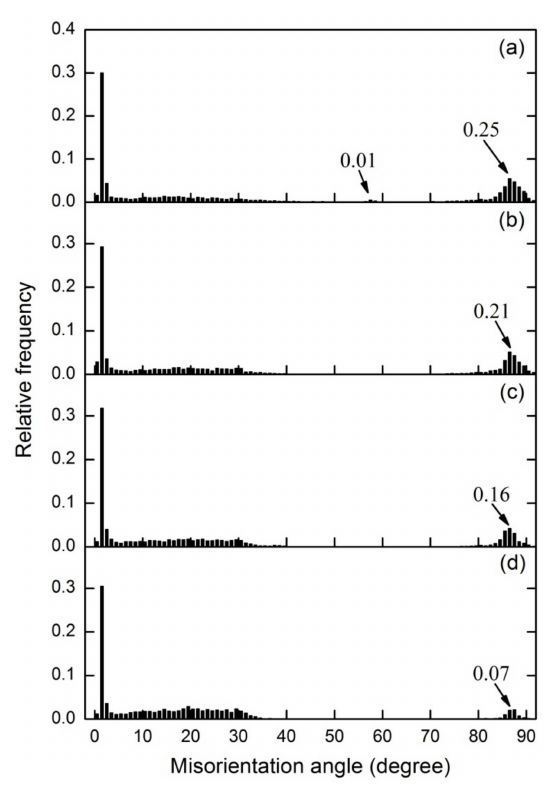
Figure 10. The grain boundary misorientation distribution in di ff erent positions in region 1 of FSW AZ31 joint after base bending ( a ) → ( d ) from below to top.